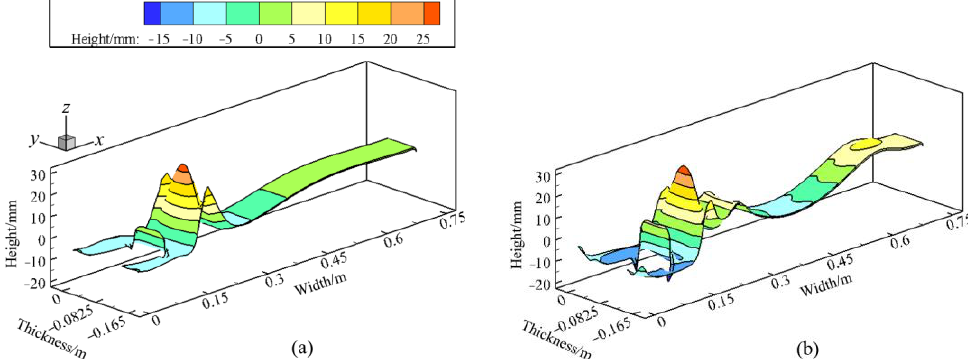
Figure 17. Effect of magnetic flux density on level fluctuation in the FTSR mold: ( a ) B max = 0 T and ( b ) B max = 0.5 T.